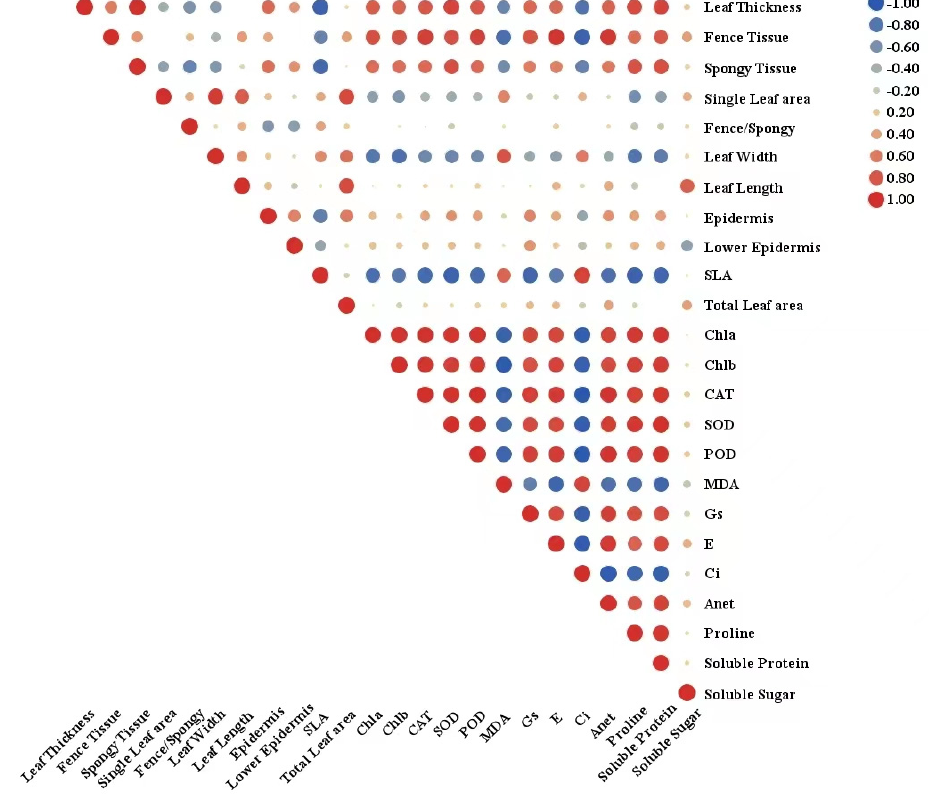
Figure 9. Heatmap of the correlation between leaf structure and physiological indices of lily under drought